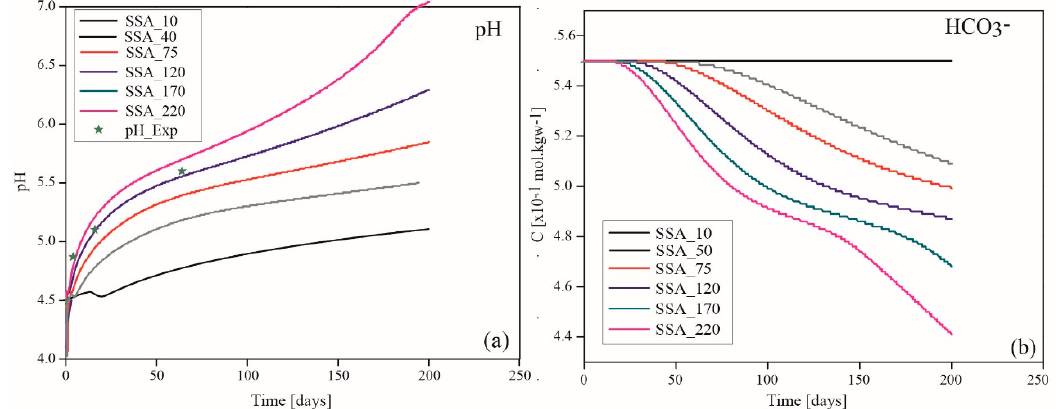
Figure 7. ( a ) Simulated pH variations of the outlet fluid compared with the measured pH; ( b ) simulated dissolved CO 2 (as HCO 3 − ) variations as a function of time computed with different specific surfaces. The measured HCO 3 − values are obtained after opening the chamber and are not relevant for comparison.